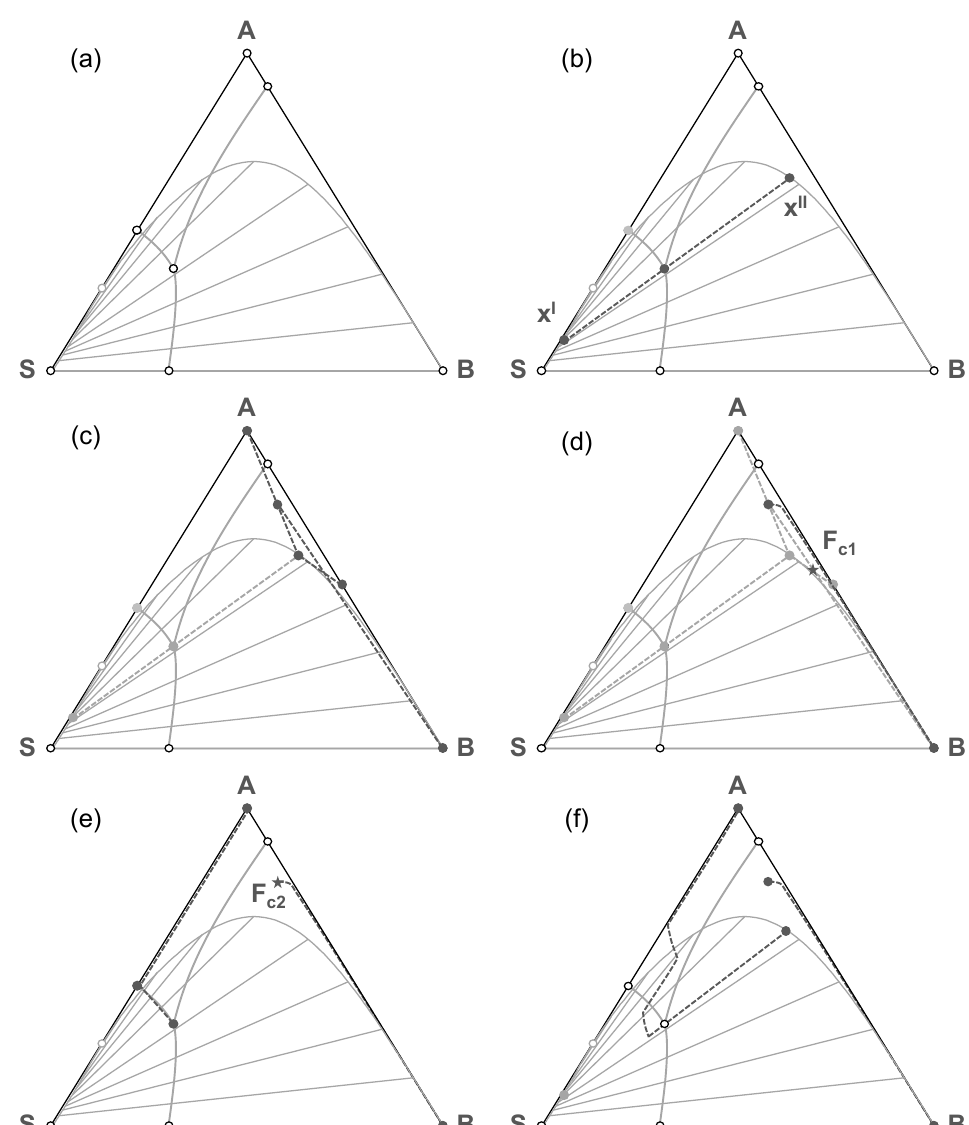
Figure 3. Depiction of the initialization procedure for heteroazeotropic distillation columns exem- plarily demonstrated for a ternary minimum-boiling azeotrope. ( a ) Determination of azeotropes, ( b ) decanter calculation, ( c ) solving overall mass balances, ( d ) calculation of the homogeneous column, ( e ) initial composition profile of the heteroazeotropic column, ( f ) calculation of the het- eroazeotropic